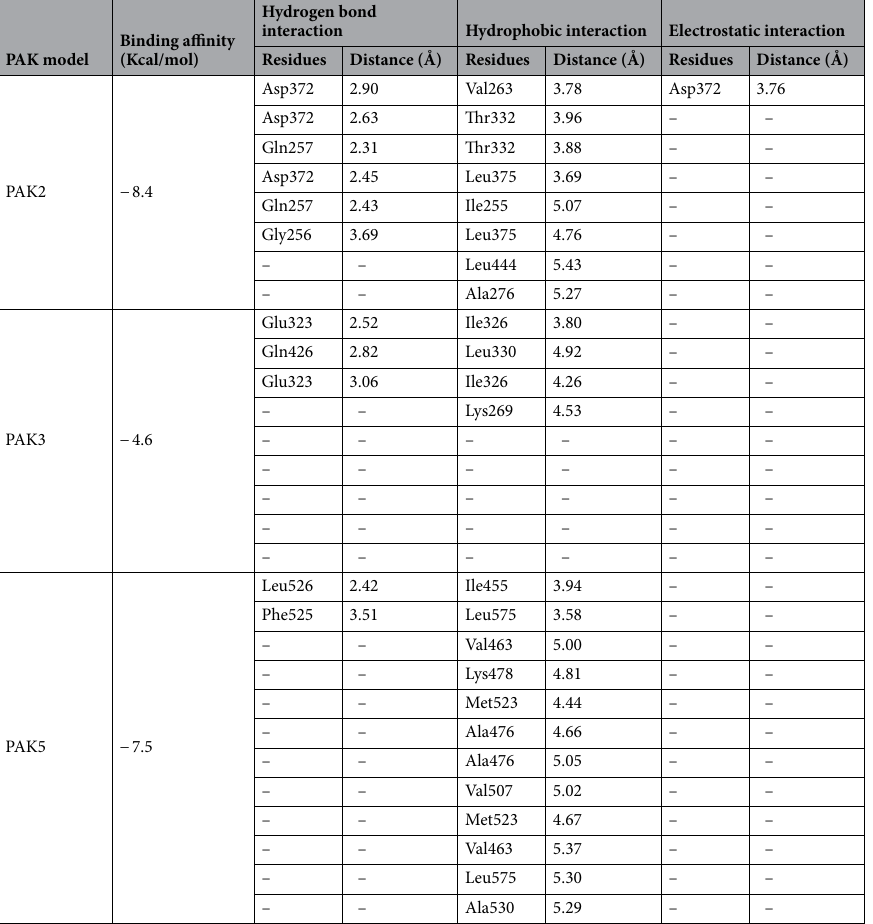
Table 6. Binding affinities and molecular interactions of 15K with the modelled structures of PAK2, PAK3 and